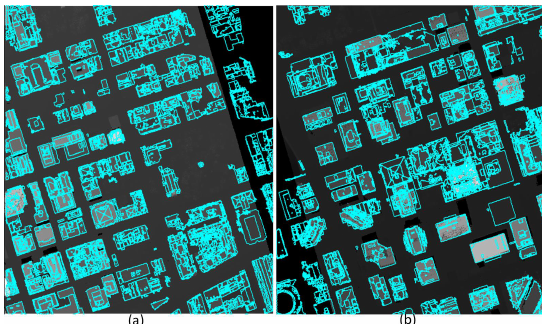
Figure 12: Extracted roof planes in the Toronto data set: (a) Area 4 and (b) Area